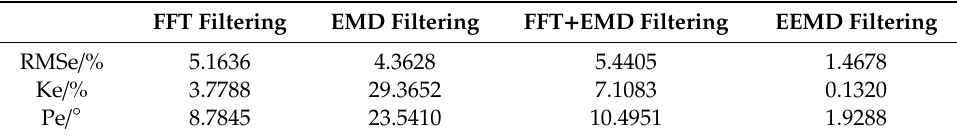
Table 2. Analysis table of integral result error.